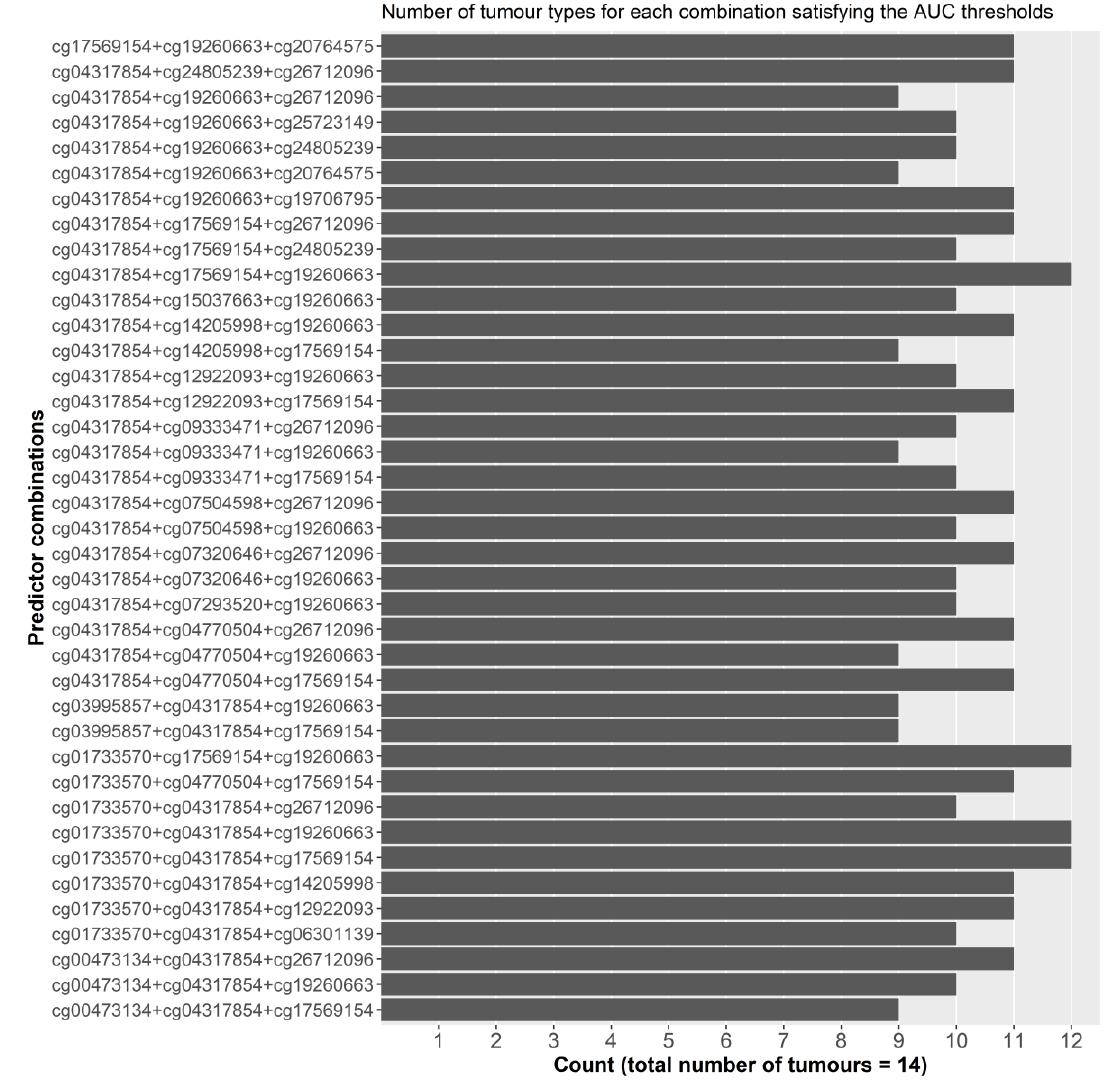
Figure 4. Countplot of the number of tumor types per combination that satisfy the AUC filters.